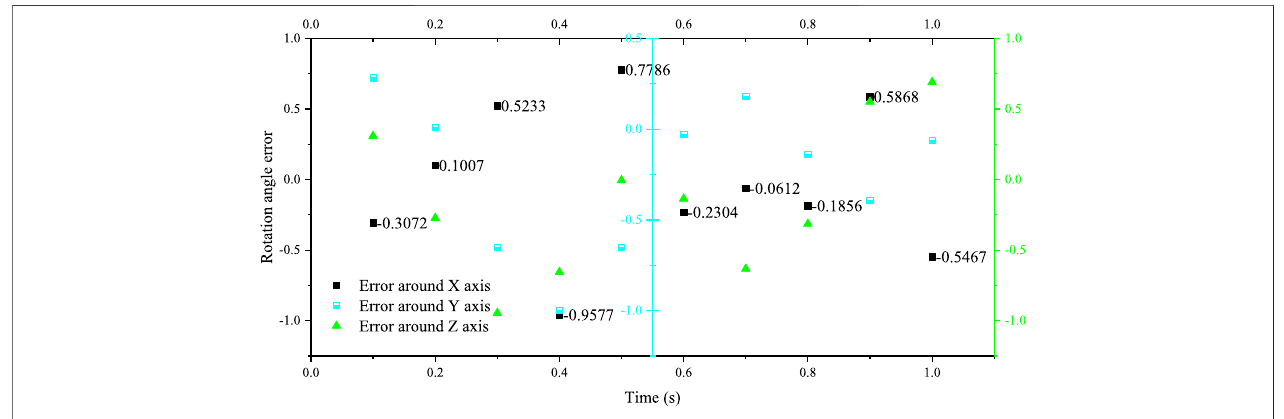
FIGURE 4 | Analysis of the angle error of the moving